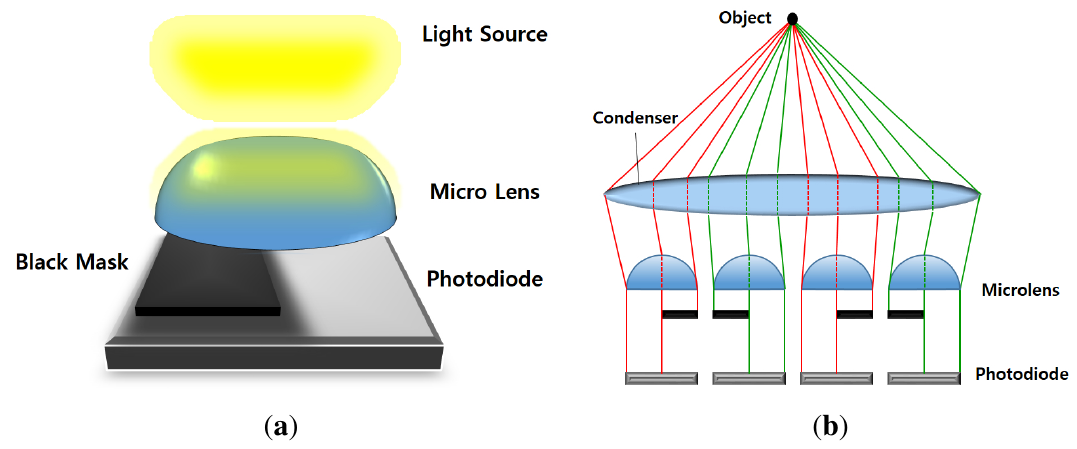
Figure 2. The sensor-based PDAF system: ( a ) the photodiode sensor model; and ( b ) the concept of generating the phase difference in the sensor-based AF